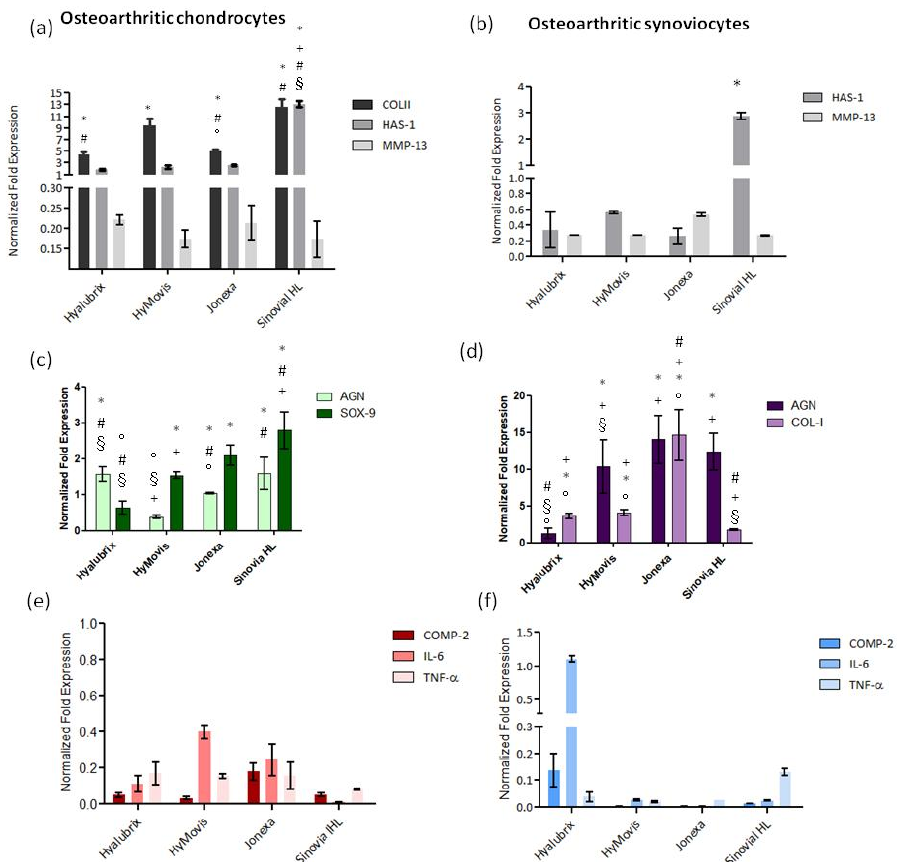
Figure 5. Gene expression analyses normalized with respect to pathological untreated cells (CTR) for COLII, HAS-1, MMP-13 ( a ), AGN and SOX-9 for chondrocytes ( c ), and HAS-1, MMP-13 ( b ), AGN and COL-I for synoviocytes ( d ). In addition, specific inflammation biomarkers (COMP-2, TNF- α , and IL-6) were accomplished for both chondrocytes ( e ) and synoviocytes ( f ). Comparative analyses were performed between a linear HA (Hyalubrix ® ), two chemically modified HAs (HyMovis ® and Jonexa Hyalastan SGL-80™), and an HA hybrid cooperative complex (Sinovial HL ® ). The data show the averages to be ± S.D. The statistical significance was analyzed through one-way ANOVA and the Tukey post hoc test for comparison of a family of 5 estimates: * p < 0.01 vs. untreated-cells (CTR); # p < 0.01 vs. HyMovis ® , § p <0.01 vs. Jonexa Hyalastan SGL-80™; ° p < 0.01 vs. Sinovial HL ® ; + p < 0.01 vs. Hyalubrix ® .